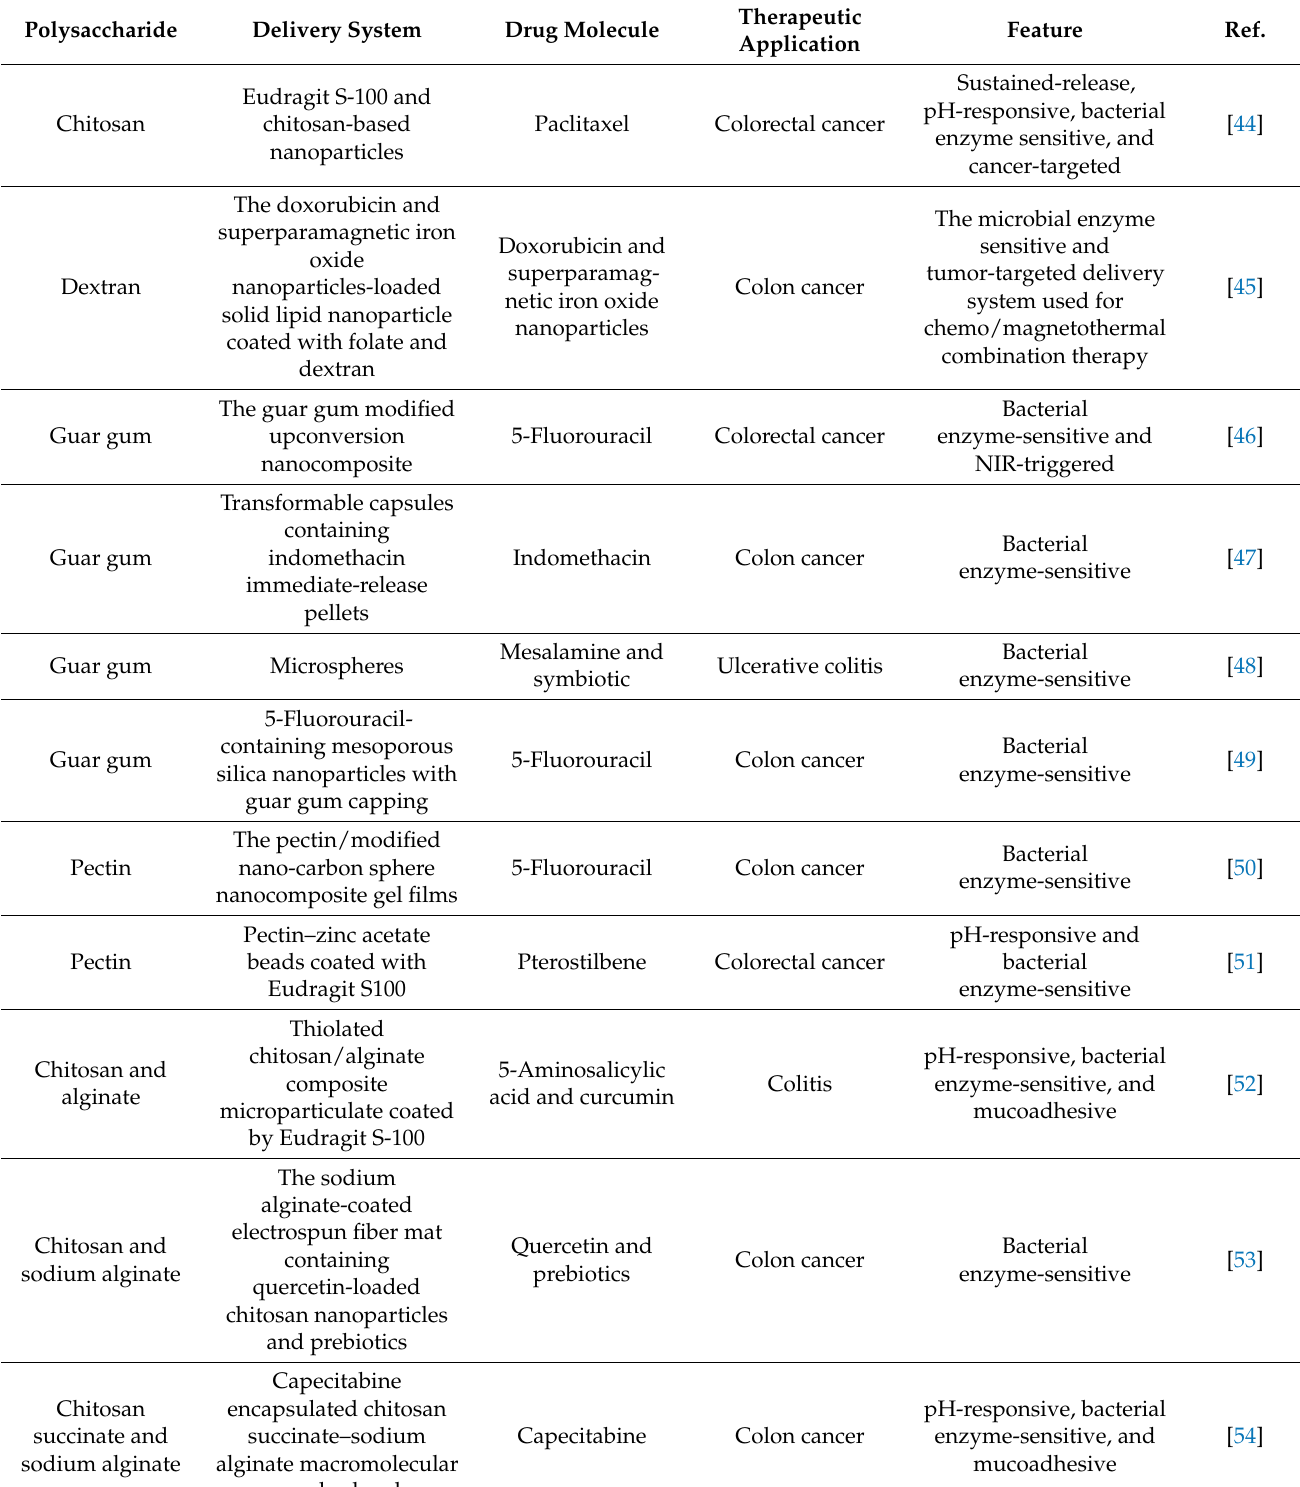
Table 1. A list of encapsulated/coated polysaccharide-based drug delivery systems for colon targeting.